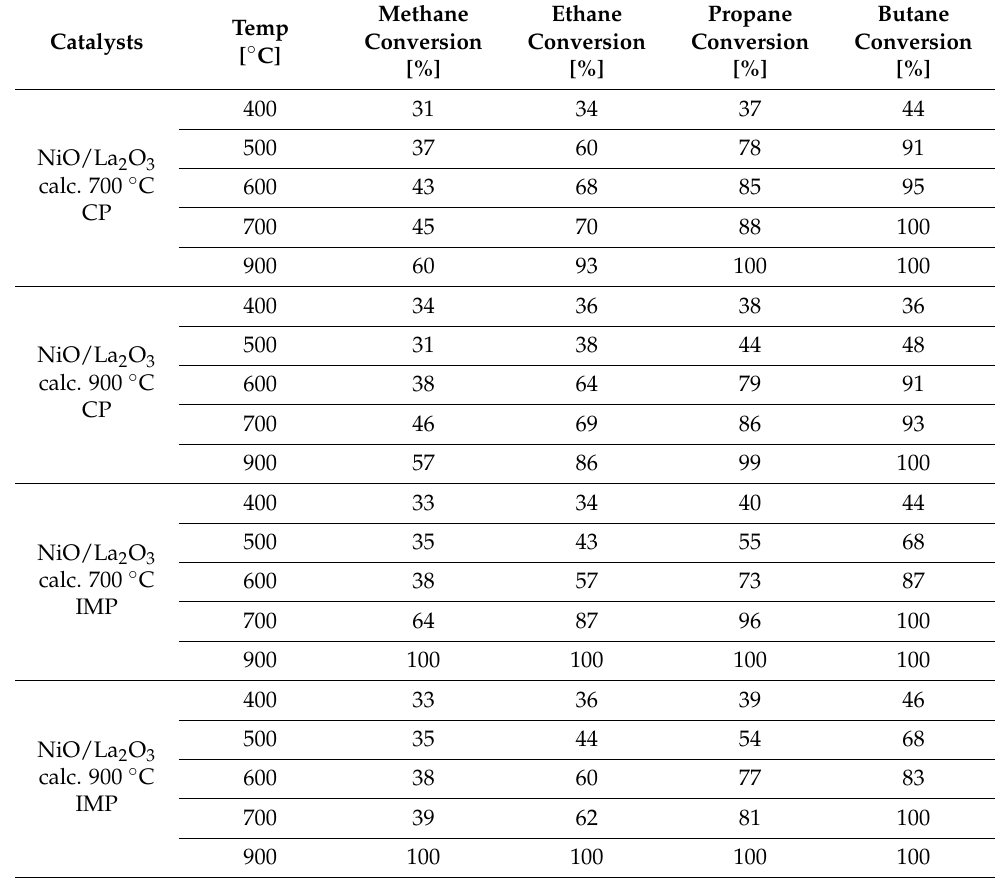
Table 1. Conversion values of the hydrocarbons obtained in the oxy-steam reforming of liquefied natural gas (LNG) process over NiO/La 2 O 3 catalysts.